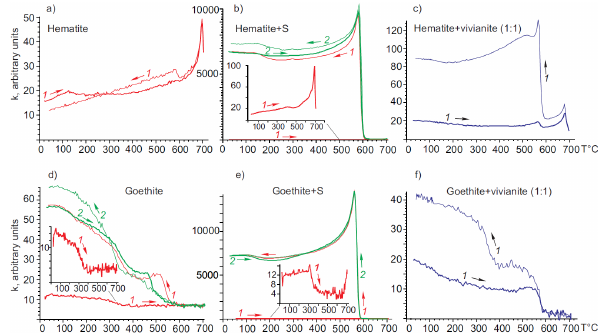
Fig. 10. Susceptibility versus temperature curves of hematite and goethite mixed with sulfur and with vivianite (1 : 1). The arrows and cursive numbers indicate the heating and cooling Figure 9 2 Fig. 9. Susceptibility versus temperature curves: (a, d) – in air; (b) – with sucrose; (c) – with carbamide; (e) – with arsenic; (f) chal- copyrite heating in air (ch) and with arsenic (ch + As); (g, h) – with sulfur. The arrows indicate the heating and cooling runs.